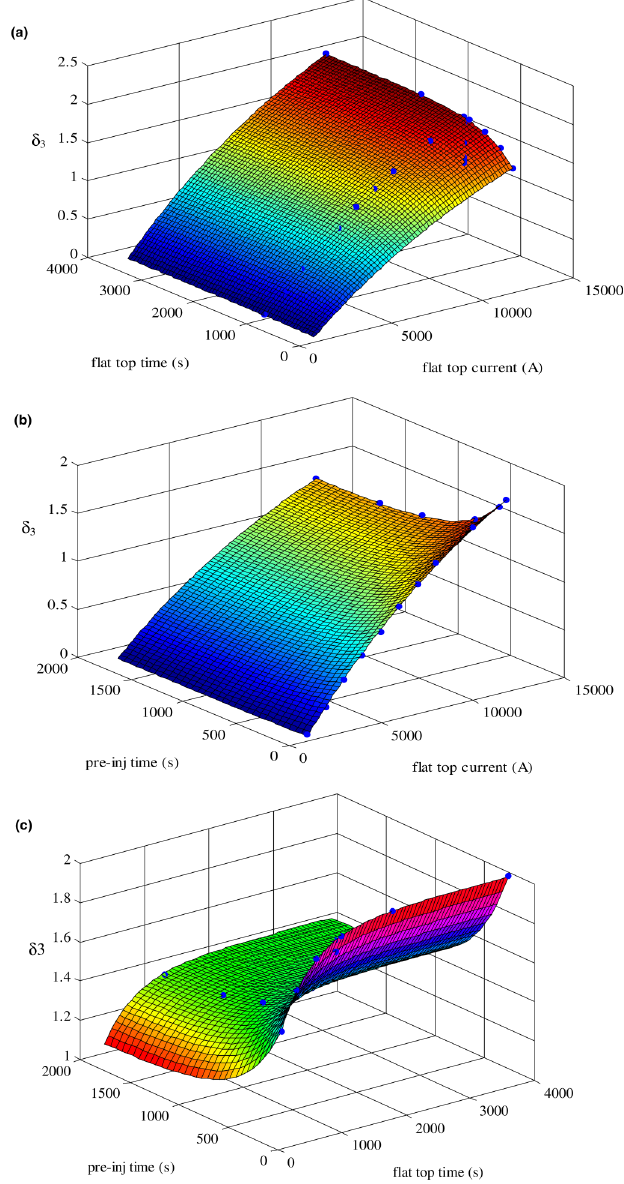
FIG. 16. (Color) Plot of the surface of (cid:1) in the space defined by 3 variations of (a) flattop current and flattop time, (b) flattop current and preinjection time, (c) preinjection time and flattop time as generated with the parameters of Table V and represen- tative for the LHC behavior. The measured values are depicted by the blue